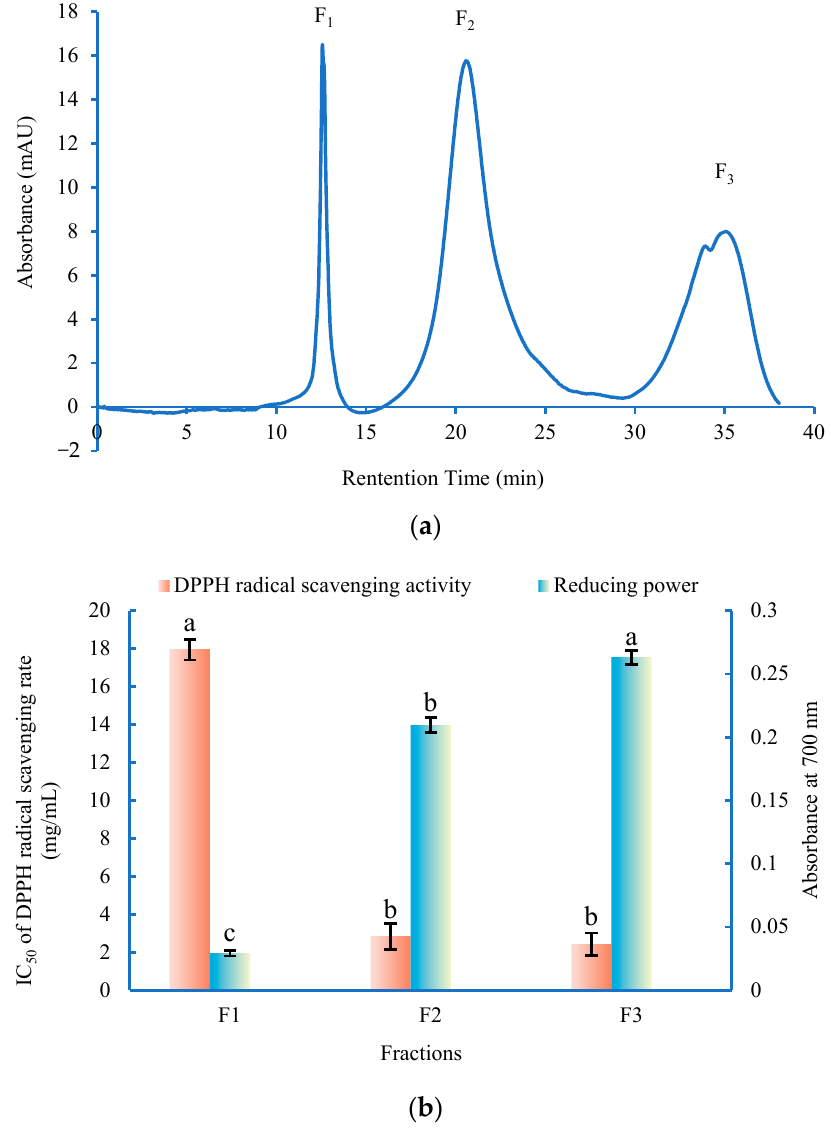
Figure 3. Separation of G. livida hydrolysate by semi-preparative RP-HPLC and the antioxidant activities of the peptide fractions. ( a ) Semi-preparative RP-HPLC; ( b ) The reducing power (at 4 mg/mL) and the IC 50 of DPPH radical scavenging rate of the fractions. Different letters on the top of the same pattern column indicate the significant difference between the fractions in the same test ( p < 0.05).